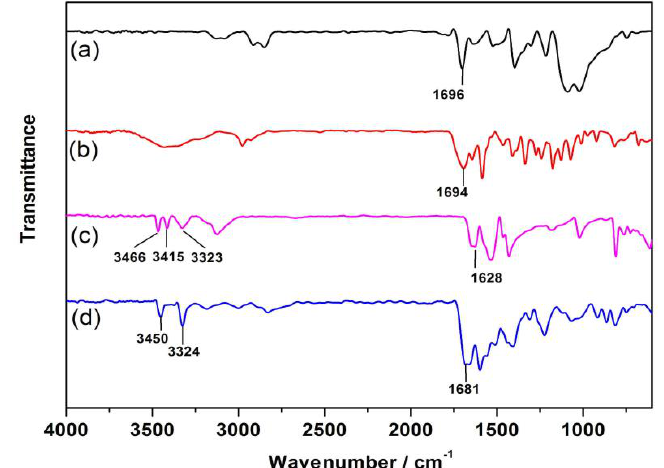
Figure 6. FTIR spectra of Fe 3 O 4 /Au–AOA ( a ), AOA–RhB ( b ), melamine ( c ), and